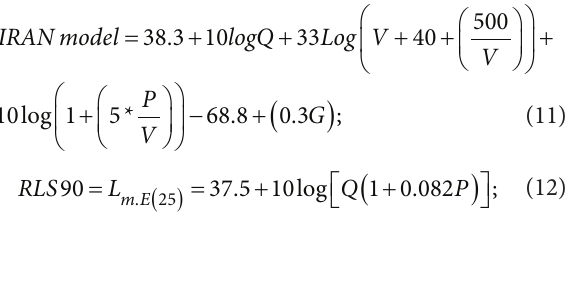
Table 9. Comparison of proposed neural network with other well-known